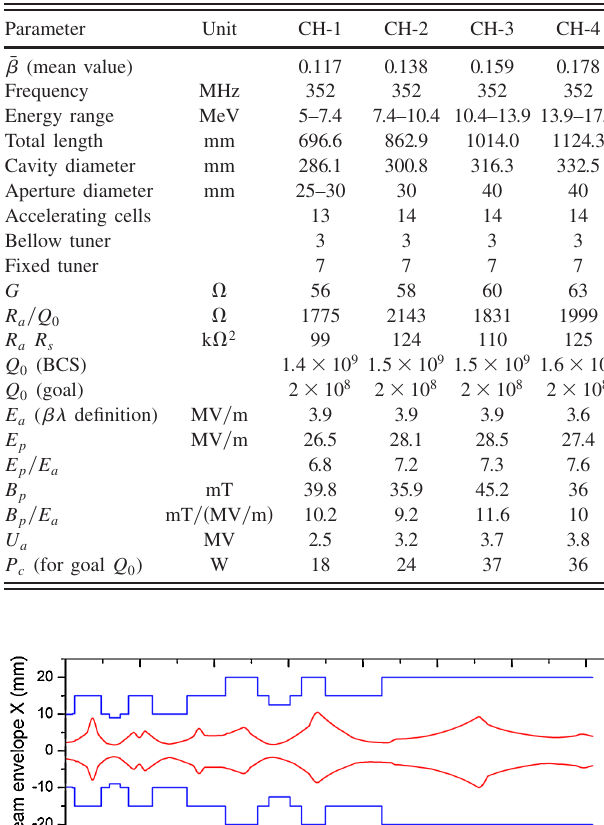
TABLE V. Main parameters of the superconducting CH cav- ities for the EUROTRANS front end.